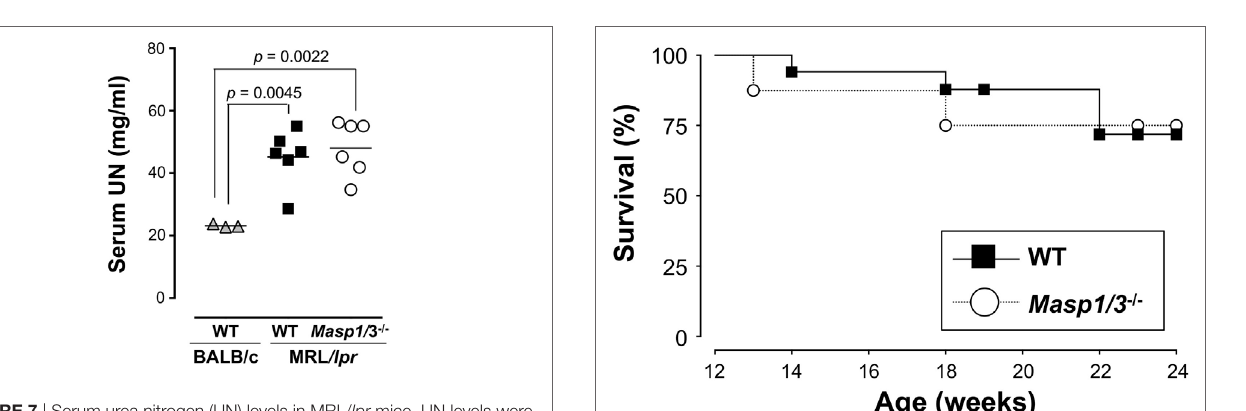
FigUre 7 | Serum urea nitrogen (UN) levels in MRL/ lpr mice. UN levels were measured using sera from WT and Masp1/3 − / − MRL/ lpr mice at the age of 24 weeks ( n = 6 in each group). Sera from 25-week-old WT BALB/c mice ( n = 3) were used as a healthy control.